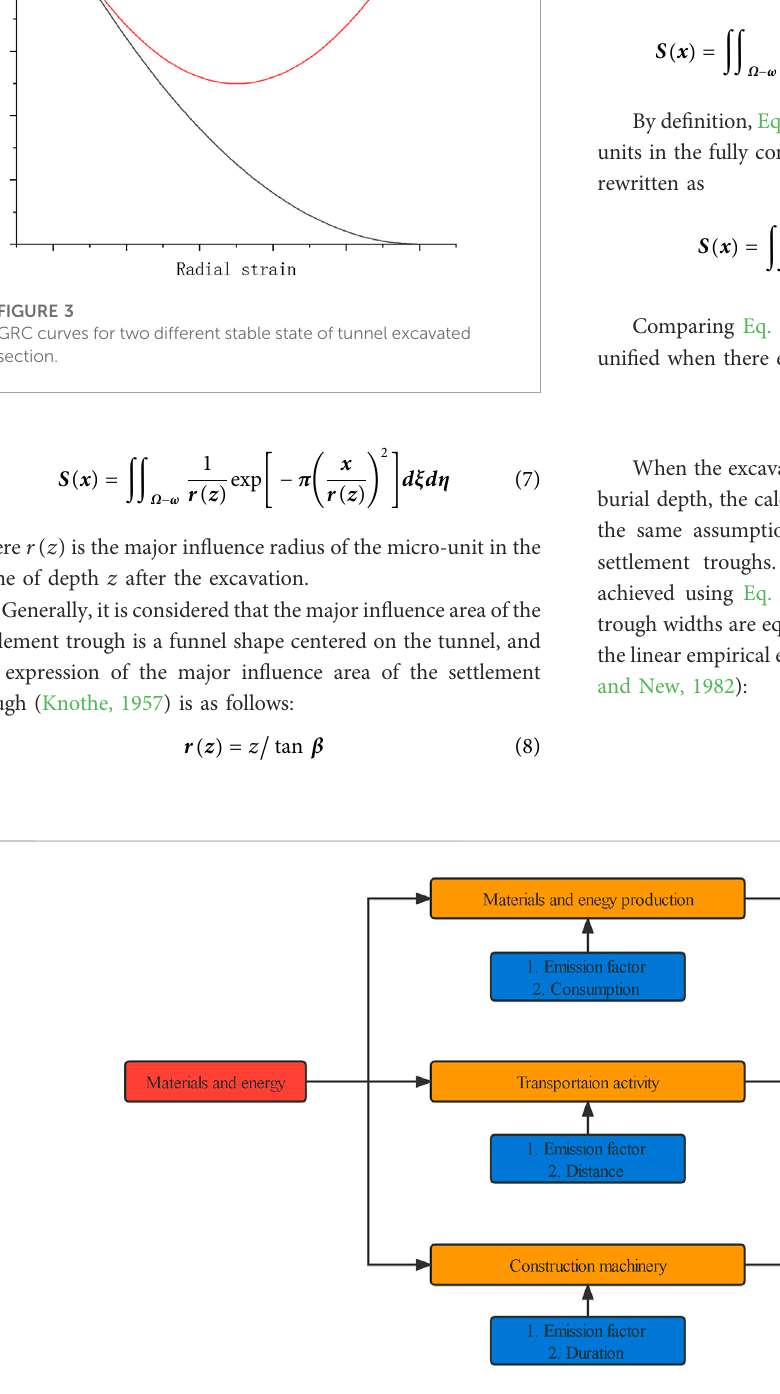
FIGURE 4 Calculation boundary of carbon emission in tunnel construction